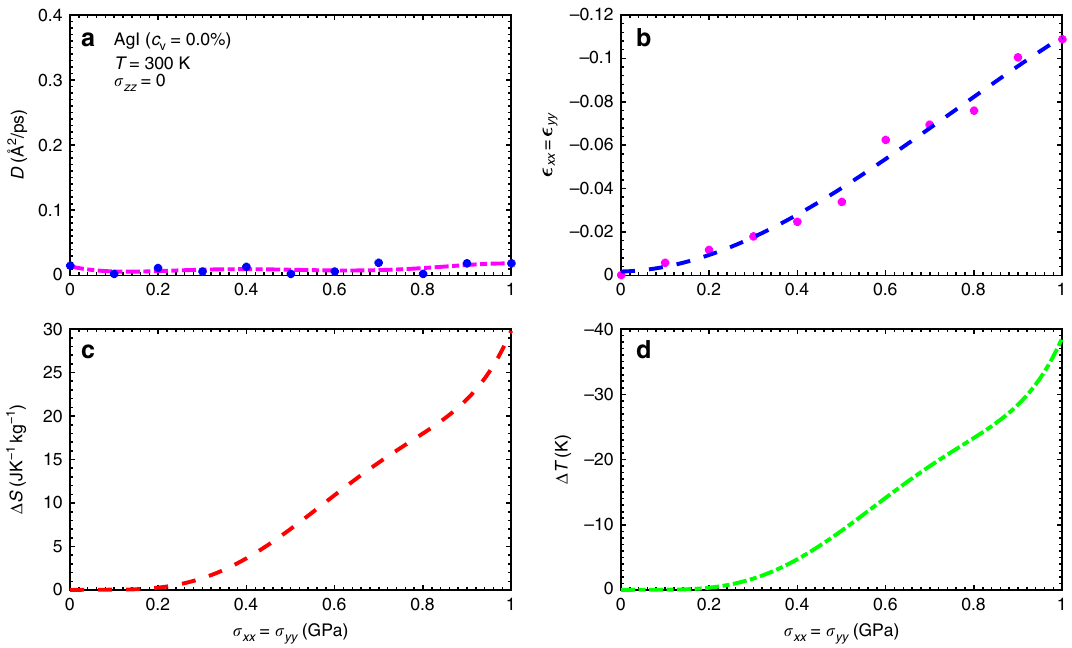
Fig. 4 Mechanocaloric effect in the AgI superionic conductor without vacancies at T = 300 K. The Ag + diffusion coef fi cient a , in-plane strain b , isothermal entropy shift c , and adiabatic temperature change d estimated at room temperature and expressed as a function of biaxial (compressive) stress. Lines in a , b are guides to